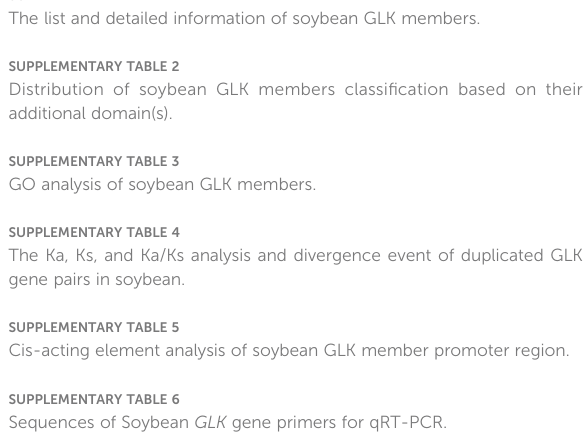
SUPPLEMENTARY FIGURE 1 Tomtom analysis of transcription factors for 15 conserved motifs. SUPPLEMENTARY TABLE 1 The list and detailed information of soybean GLK